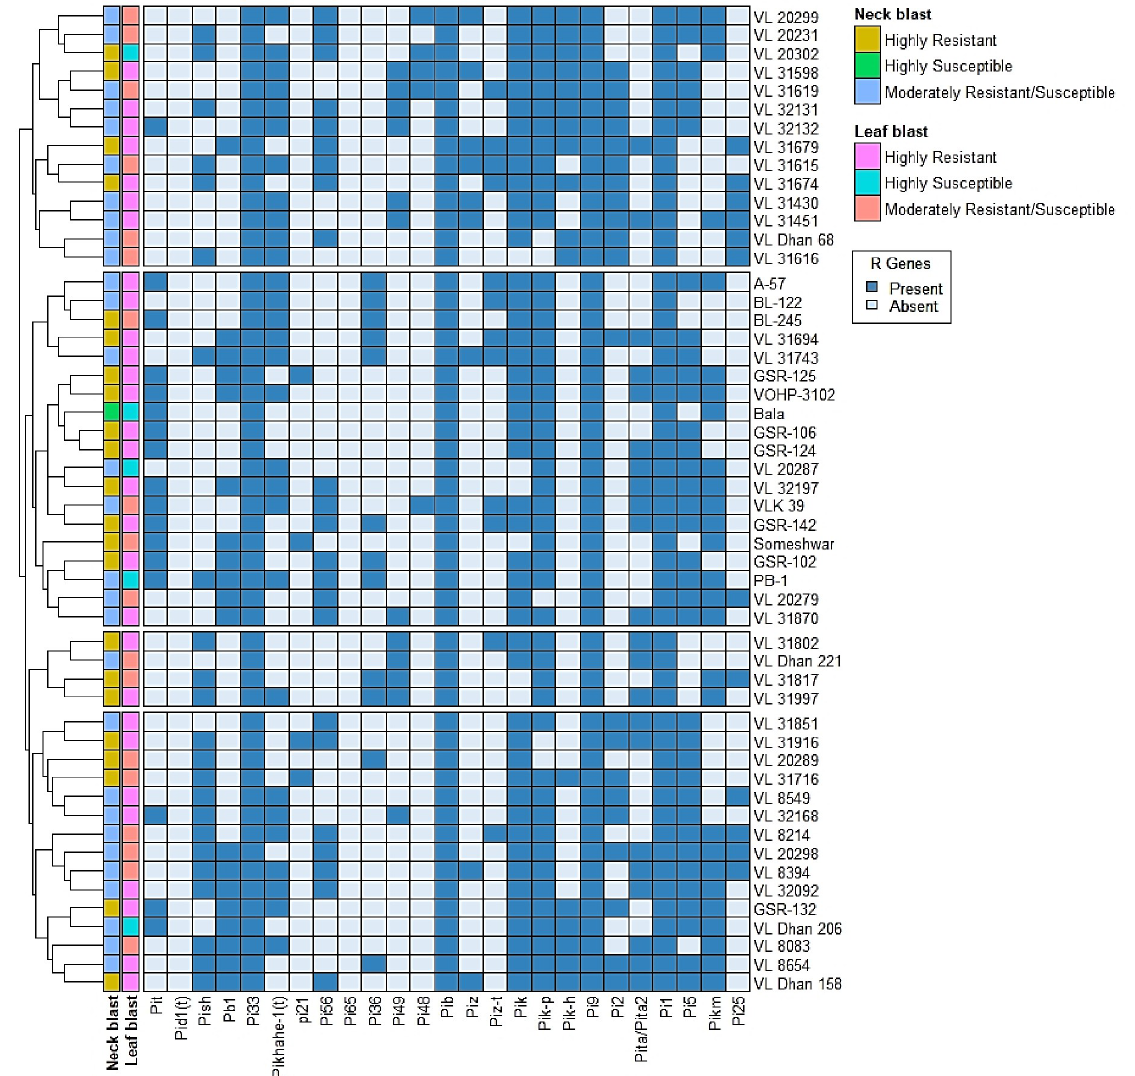
Fig 1. A clustered analysis based on the 25 molecular markers and Heatmap representing the summary of phenotypic and genotypic data of 52 rice genotypes analyzed in this